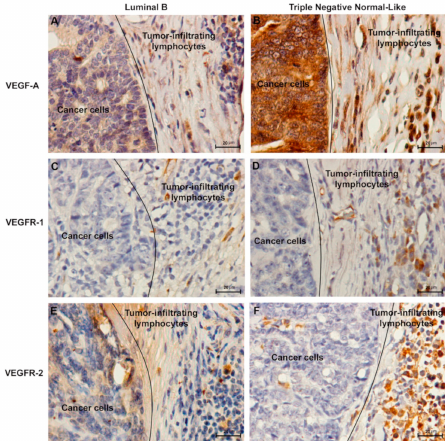
Figure 3. Representative images of immunohistochemical staining of vascular endothelial growth factor (VEGF-A), vascular endothelial growth factor receptor 1 (VEGFR-1) and receptor 2 (VEGFR- 2) in tumor infiltrating lymphocytes and cancer cells of feline mammary carcinomas. Luminal B subtype graded as TILs negative for ( A ) VEGF-A, ( C ) VEGFR-1 and ( E ) VEGFR-2. Triple Negative Normal-Like subtype with a TILs-positive score for ( B ) VEGF-A, ( D ) VEGFR-1 and ( F ) VEGFR-2. Original magnification 400 ×